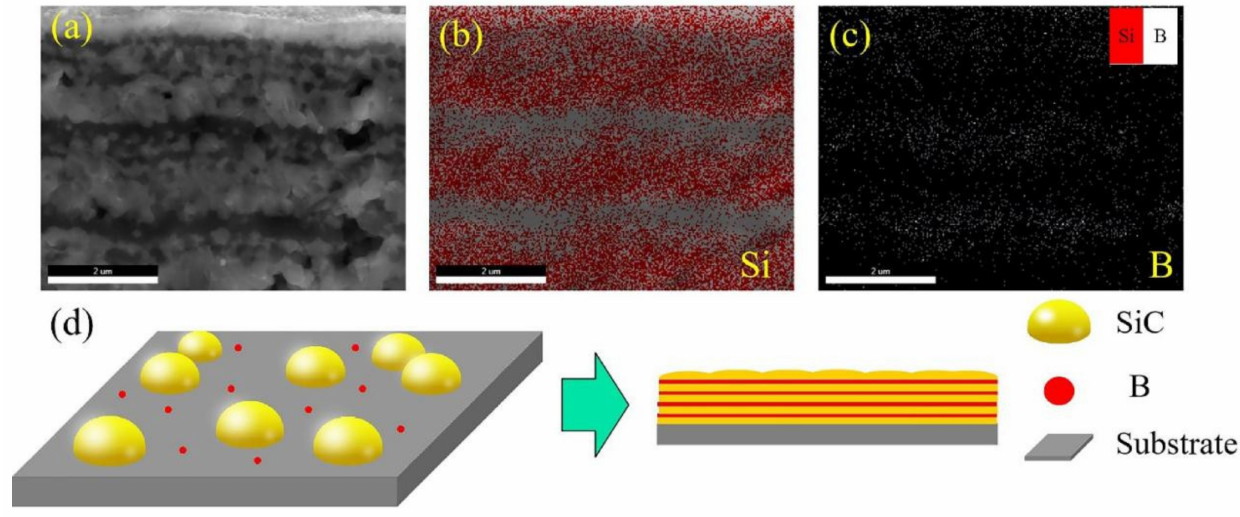
Figure 4. ( a ) SEM image of the SiC annealed at 1800 ◦ C. ( b ) EDS mapping result for the Si. ( c ) EDS mapping result for the B. ( d ) Growth process of the multi-layer